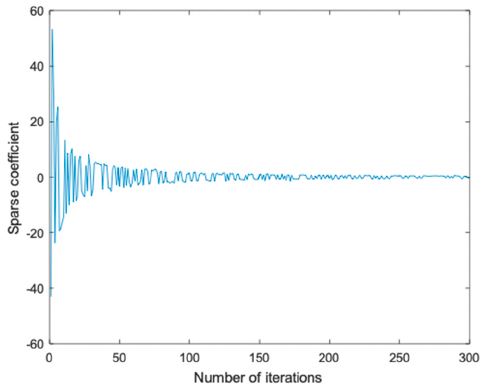
Figure 6. Iterative process of one normal current signal.